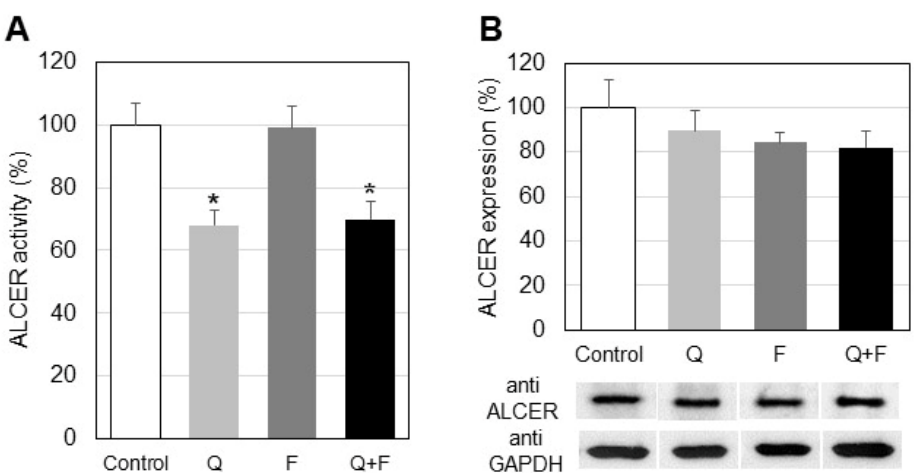
Figure 5. Alteration in the activity ( A ) and protein expression ( B ) of alkaline ceramidase (ALCER) in control and treated with quercetin (Q) and fingolimod (F) HepG2 cells. Values are expressed as % of controls (100%). Representative images from Western blot analysis with specific antibodies to alkaline ceramidase (anti-ALCER) are shown at the bottom of panel B. Reaction with anti-glyceraldehyde-3-phosphate dehydrogenase antibodies (anti-GAPDH) was used as an internal control for loading. Values are means ± SD. Statistical significance is presented as comparison of treated cells with controls. * p < 0.01.